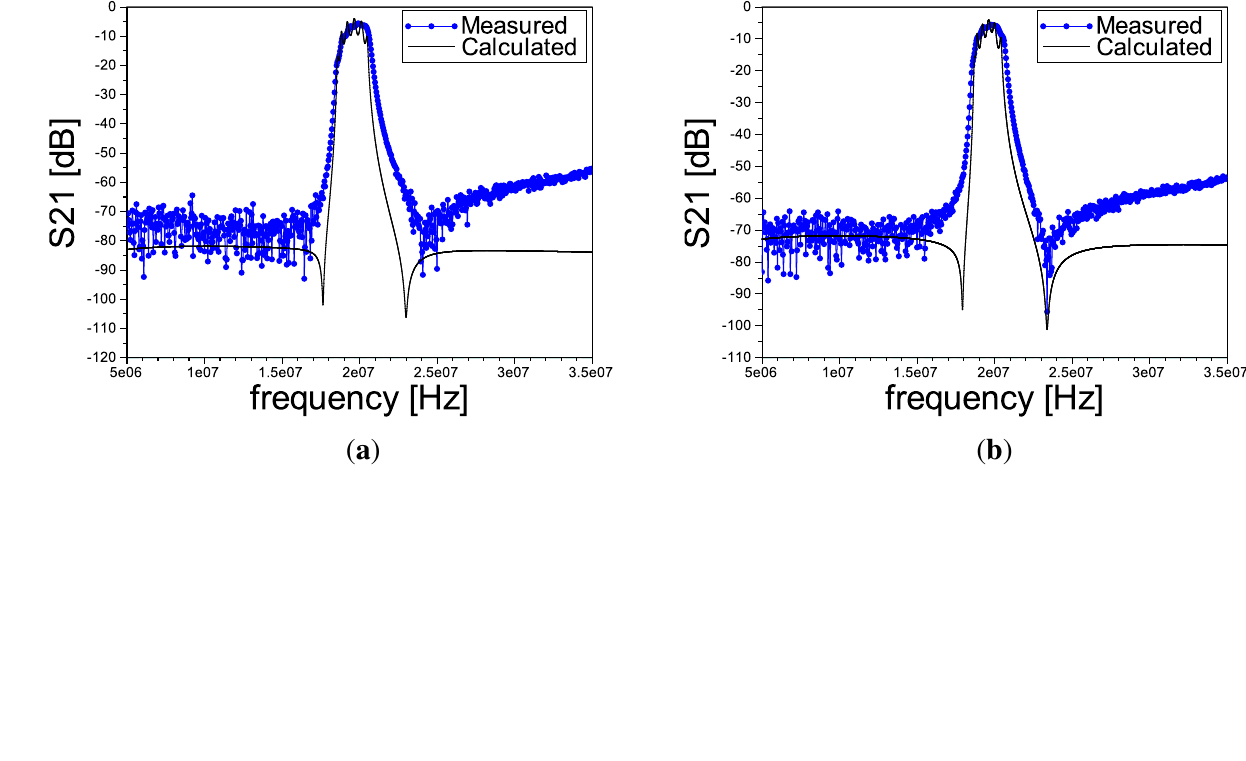
as a function of 21